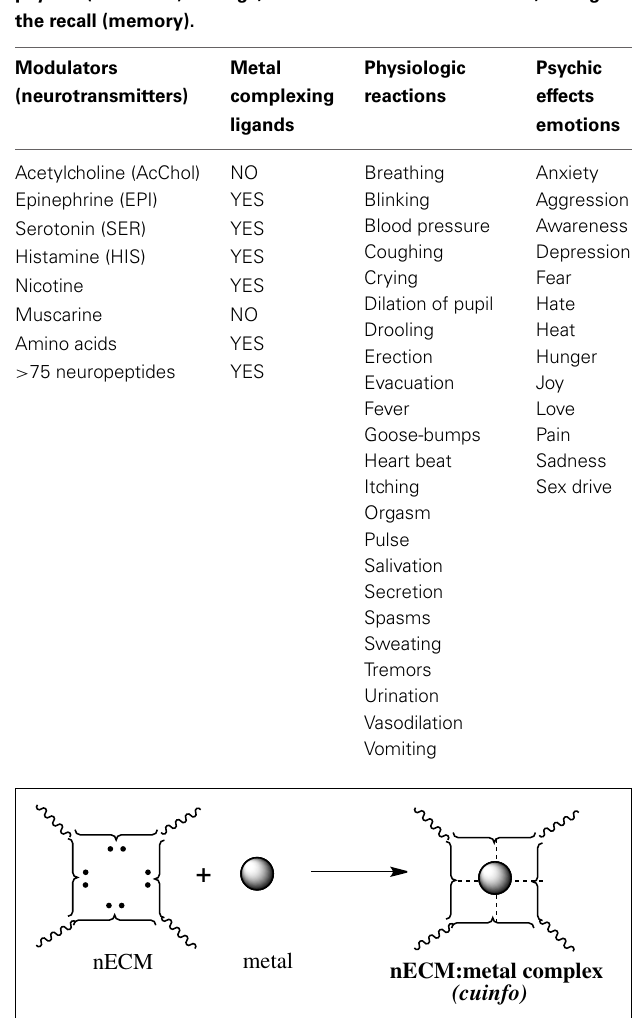
FIGURE 3 | Iconographic representation of formation of anECM:metal complex ( cuinfo ). The chelating node (address) within the nECM is presented as square electron-rich hole fixed within the nECM lattice, with 2 dots representing ligands available for capturing a metal. The metal-bonded to the complexing group electrons is indicated by a dotted line, within the cuinfo . It can serve as a binding focus for metabolites and neurotransmitters. The nECM array with metal complexes is called